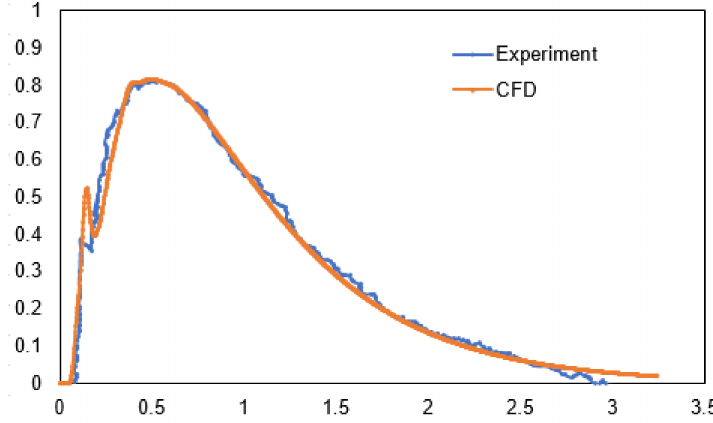
Figure 4. RTD curve of water modelling and numerical modelling results (tundish with gas